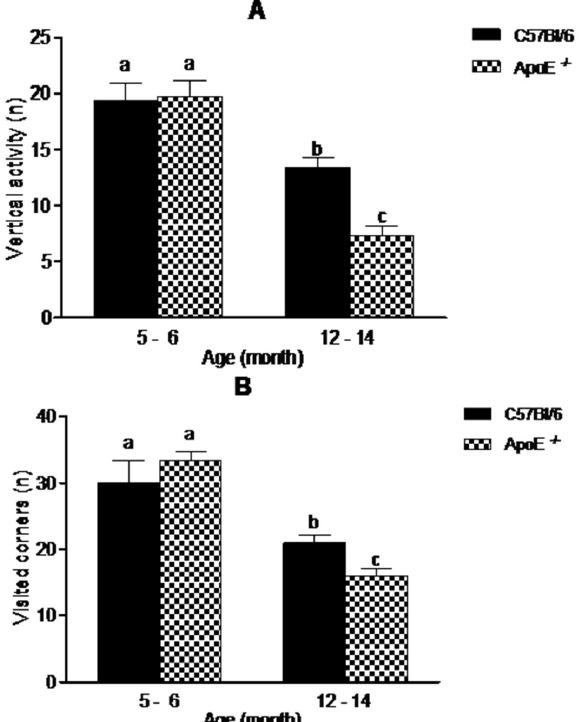
Figure 3. Reduction in exploratory behavior in open field is associated with aging in C57Bl/6 and ApoE − / − mice (n=10/sex/age/genotype) although knockout mice showed significantly decrease in exploratory activity compared with their age-matched wild-type controls. Values are expressed as combined male and female data means ± SEM. Different letters (a,b,c) represent significant difference between groups. ( A ) Vertical activity (steepness) (F(3/34) = 21.38, p = 0.000); ( B ) Visited corners. (F(3/23) = 16.38, p = 0.000). Kruskal Wallis nonparametric one-way ANOVA and Tukey’s Multiple Comparison Tests. No significant differences were found between sexes in both strains.